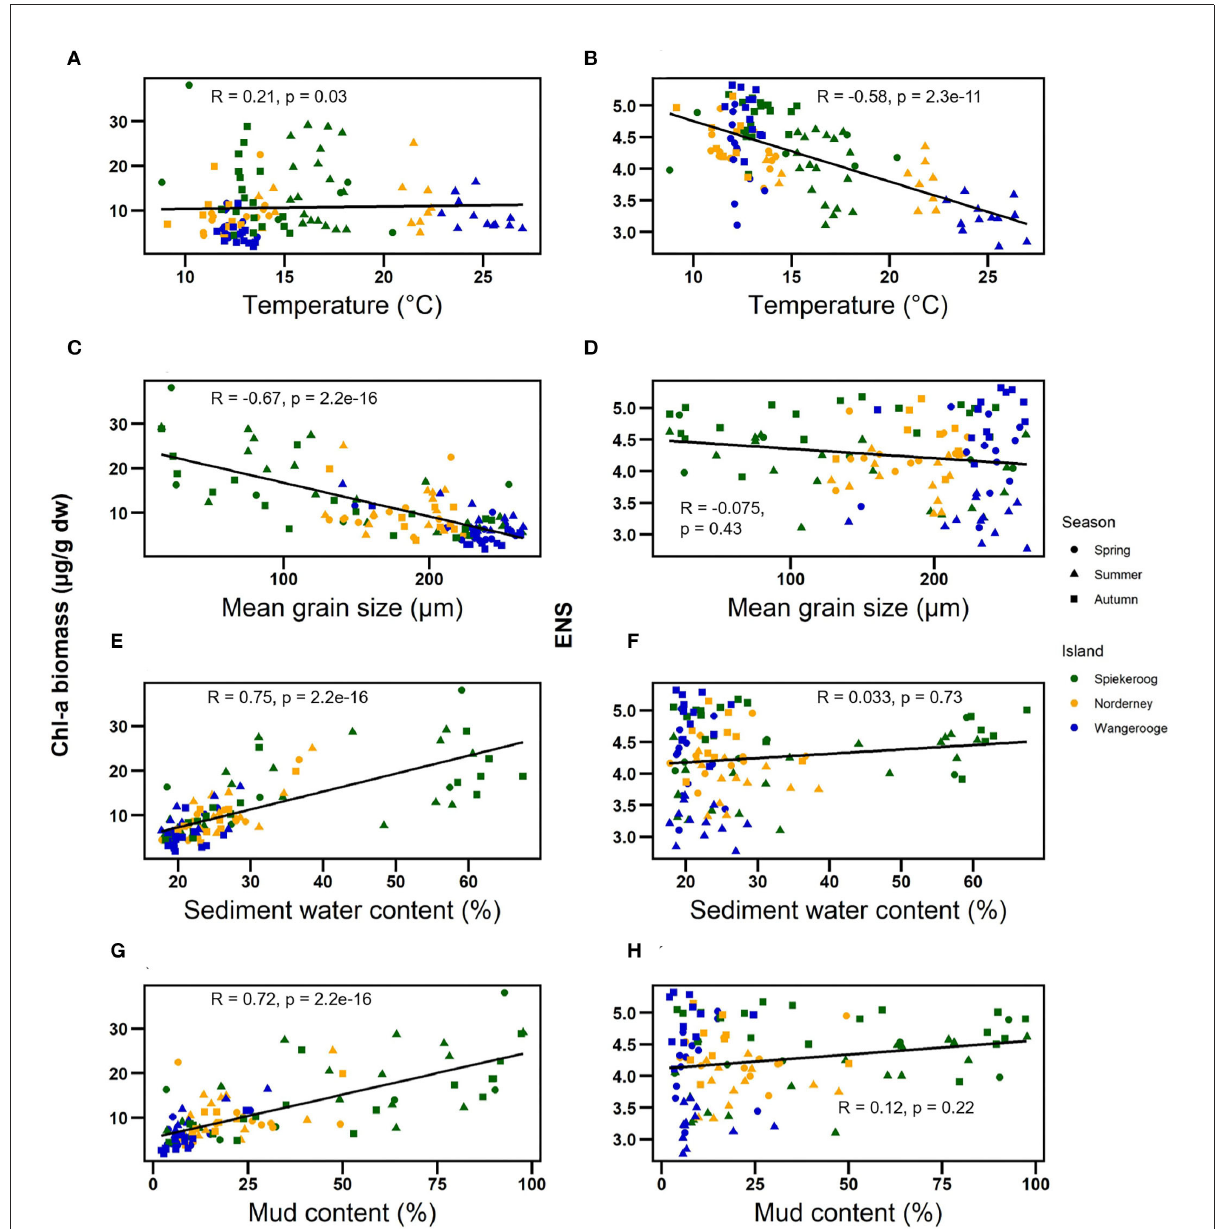
FIGURE4 Relationship between Chl-a biomass in micrograms per gram dry weight sediment ( µ g /g dw) (left panel) and pigment diversity (ENS, right panel) with physical abiotic parameters: temperature (A,B) , sediment mean grain size (C,D) , sediment water content (E,F) and sediment mud content (G,H) on natural tidal flat